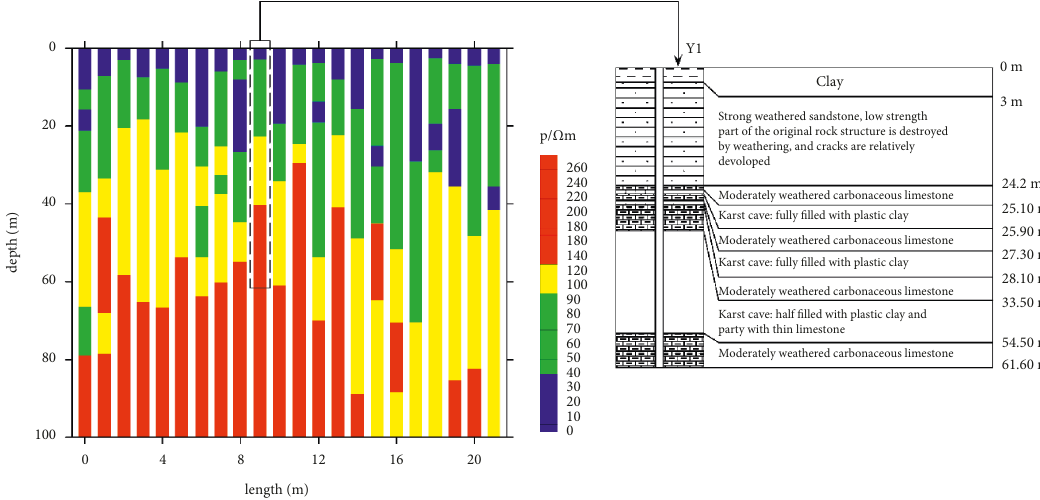
Figure 8: Comparison of inversion results (left) and borehole logging results